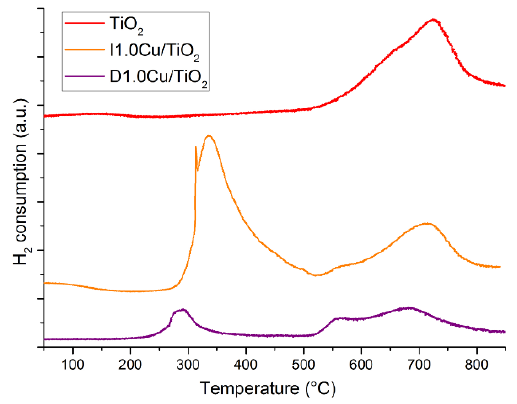
Figure 12. TPR of TiO 2 , I1.0Cu/TiO 2 and D1.0Cu/TiO 2 .